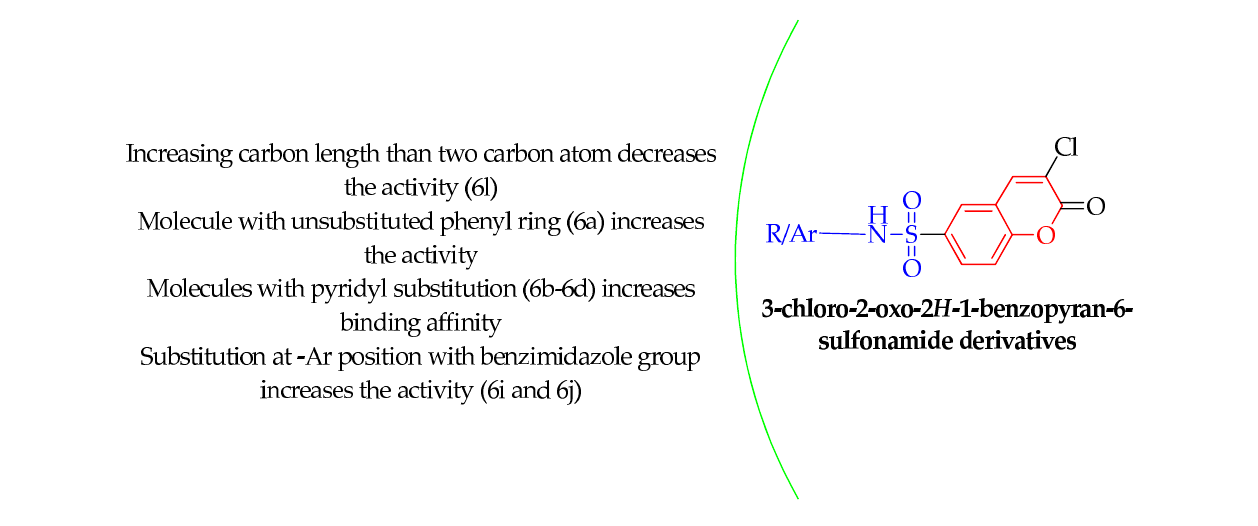
Figure 7 . Structural-activity relationship of developed compounds. Figure 7. Structural-activity relationship of developed